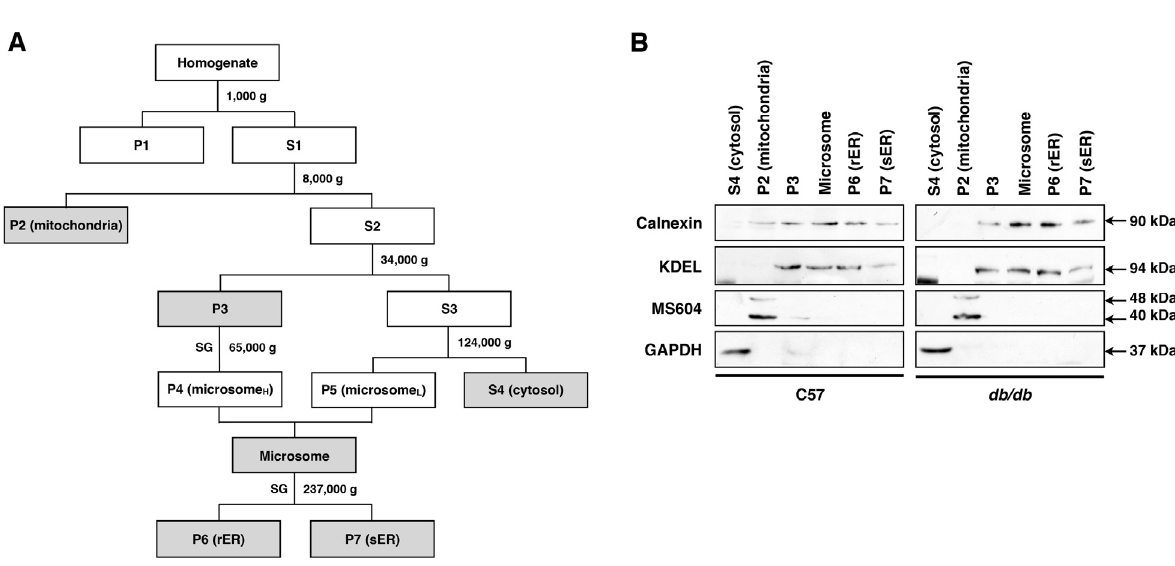
Figure 2. Subcellular fractionation of mouse liver. ( A ) Flow diagram for the subcelluar fractionation. P, pellet; S, supernatant; SG, sucrose gradient; ( B ) Immunoblot